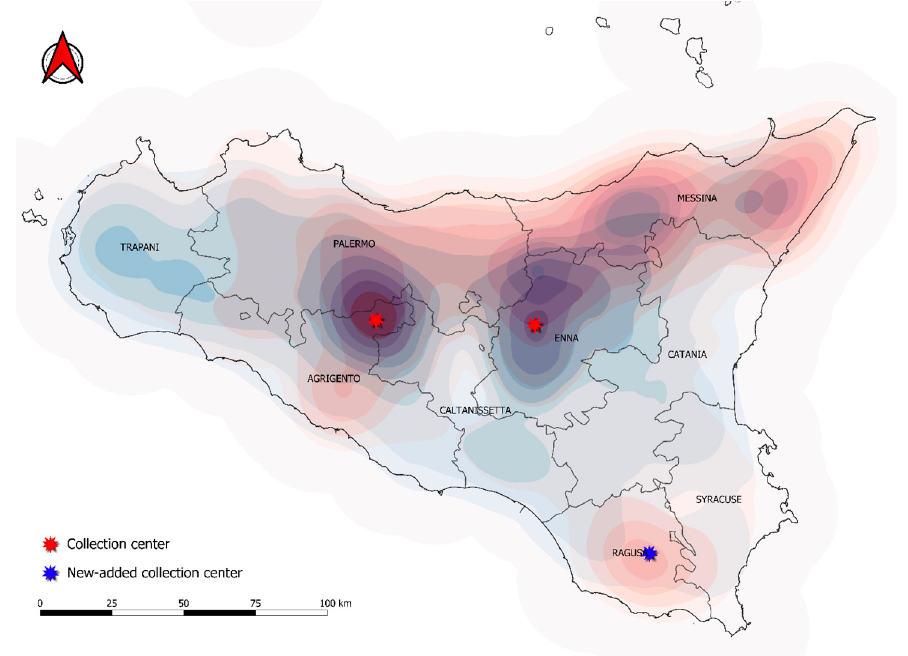
Figure 11. Identification and localization of new suitable collection centers.